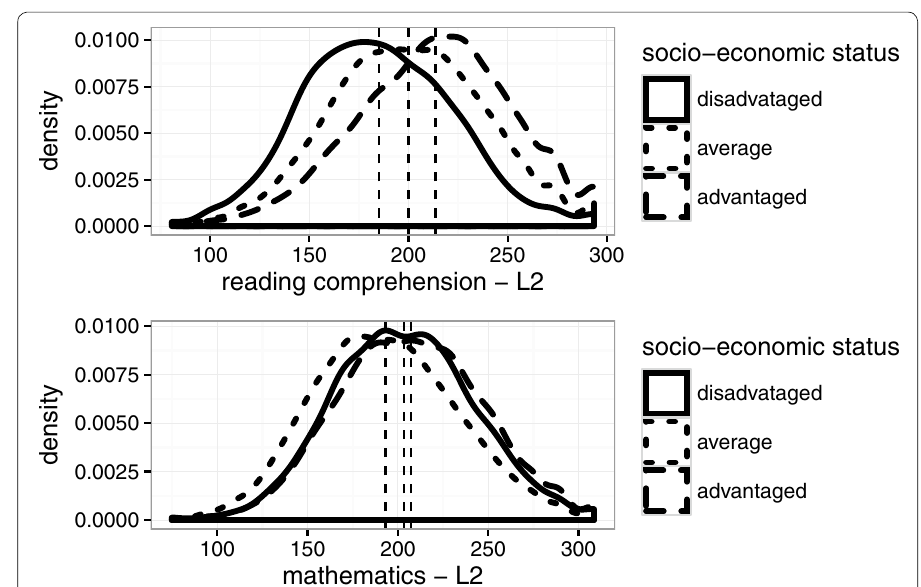
Fig. 1 Reading comprehension and mathematics achievement for second-graders according to the level of socio-economic status approximated by the highest level of parents’ education (pared). The family back- ground predictor has been divided into three classes: disadvantaged students, those having parents with years of schooling between 4 and 10; students with average living standards having parents with years of education in the interval [11, 15) and advantaged students whose parents have more than 15 years of educa- tion. The vertical dotted lines represent the group averages